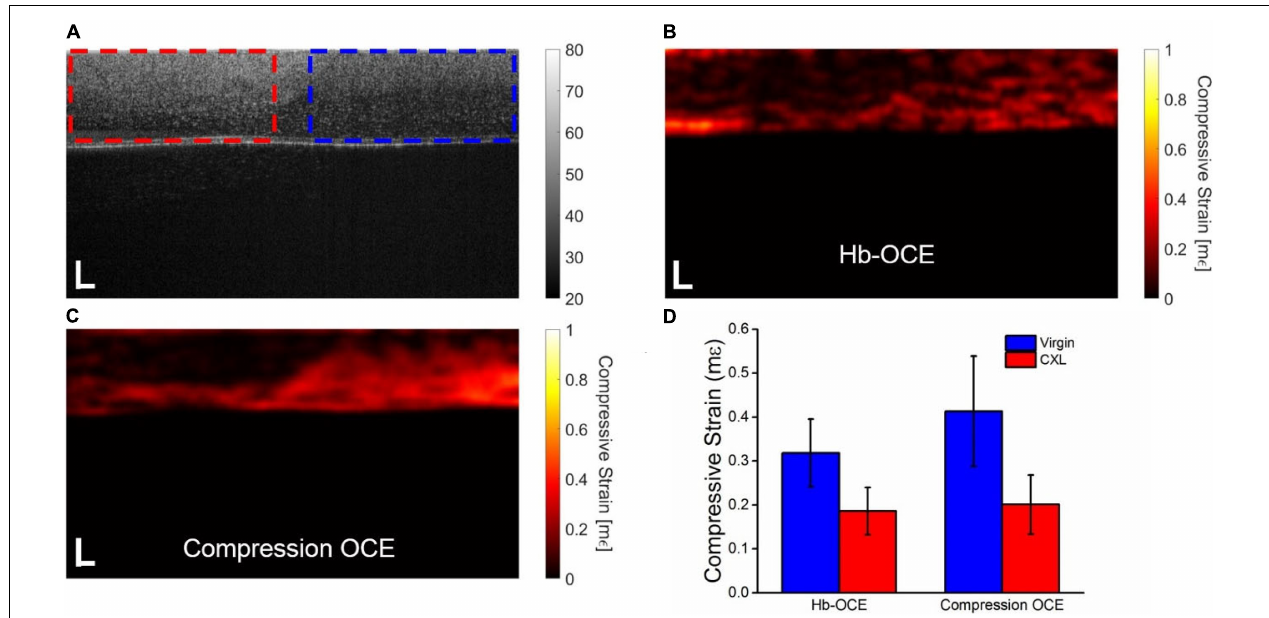
FIGURE 4 | (A) OCT intensity B-scan of a partially crosslinked cornea. The dotted boxes indicate the (red) crosslinked and (blue) virgin regions, respectively. Corneal stiffness mapped by (B) Hb-OCE and (C) compression OCE. (D) Mean and standard deviation of virgin and crosslinked regions measured by Hb-OCE and compression OCE. Scale bars are 100 µ